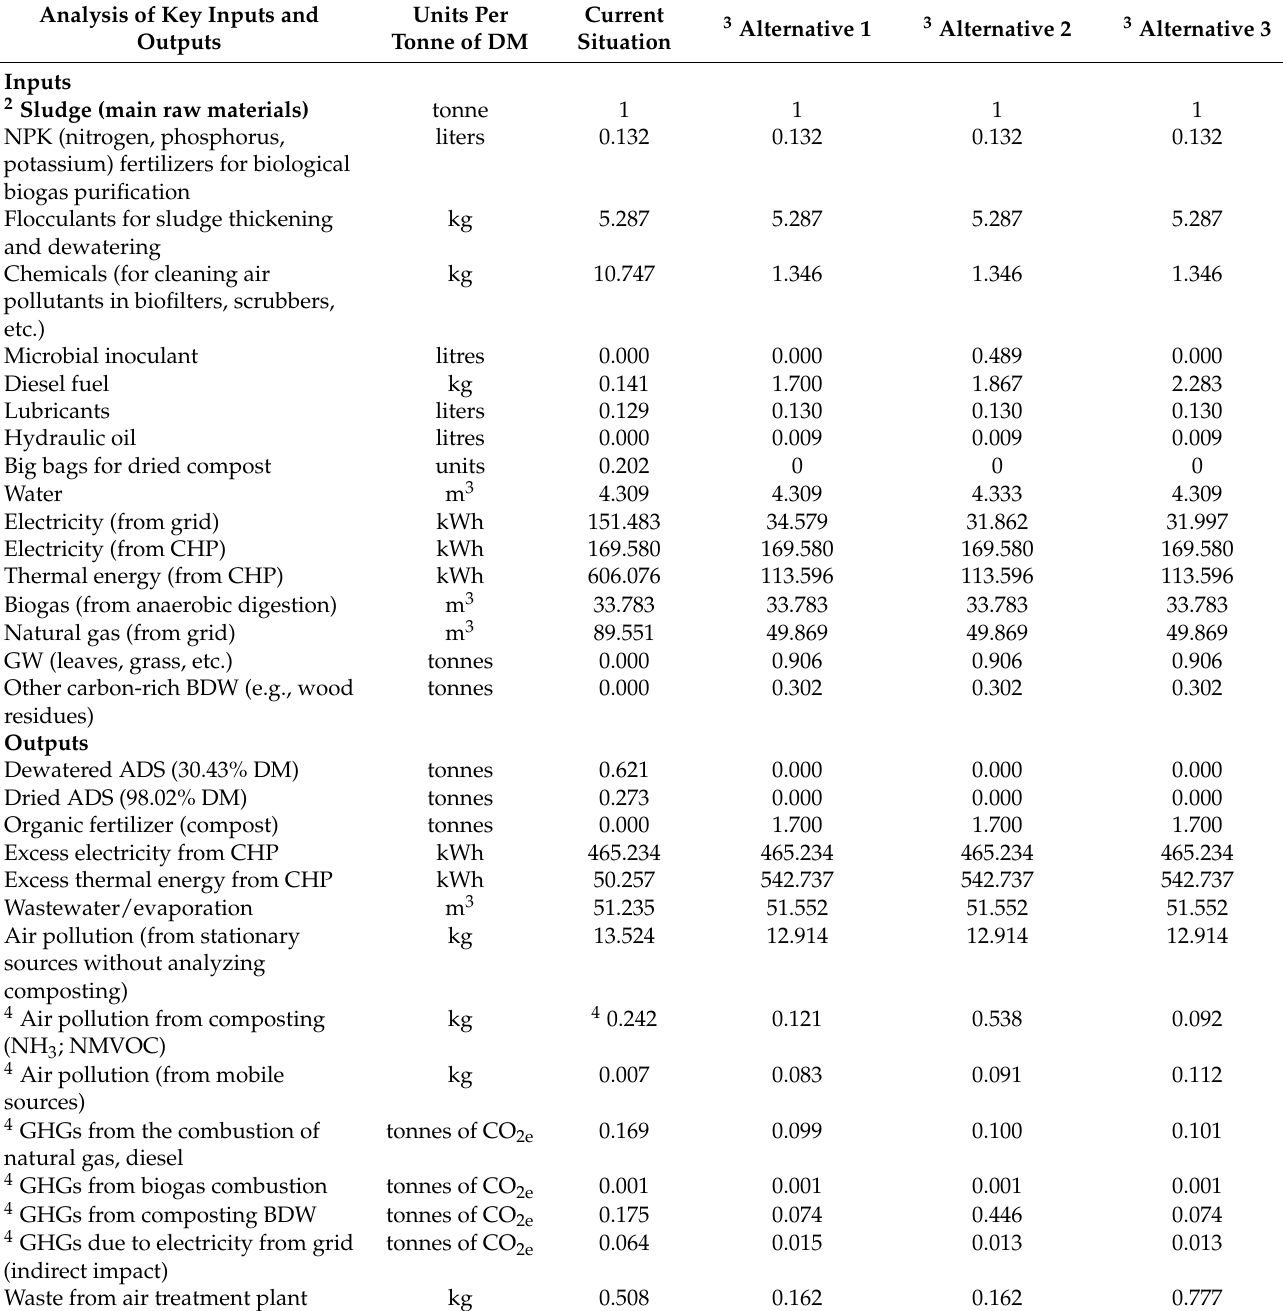
Table 5. Comparison of 1 relative environmental indicators (EI r ) of sludge management alternatives with the current